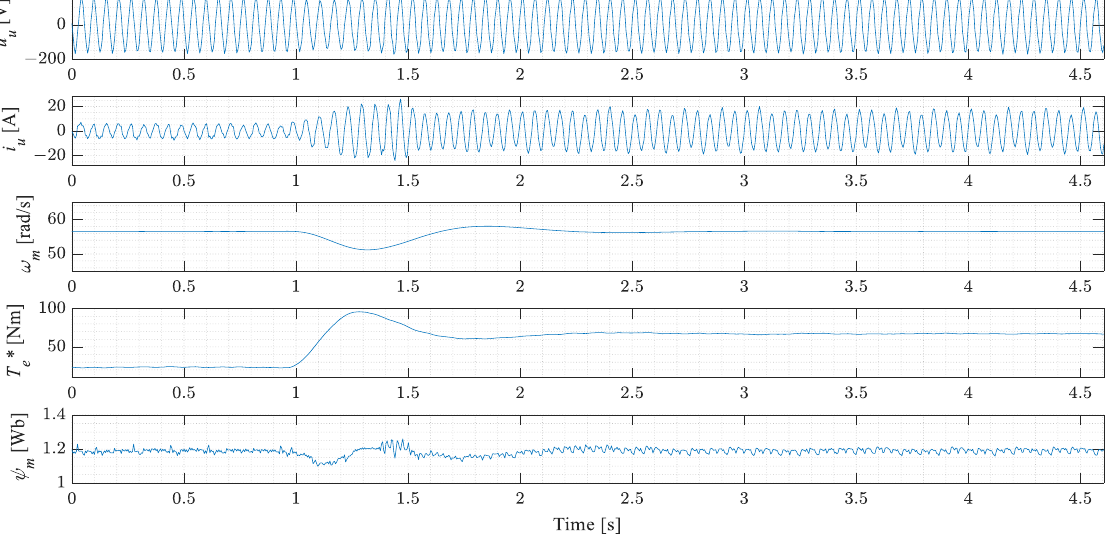
Figure 14. Experimental results of the cycloconverter drive during load torque change at 60% of the rated machine speed.